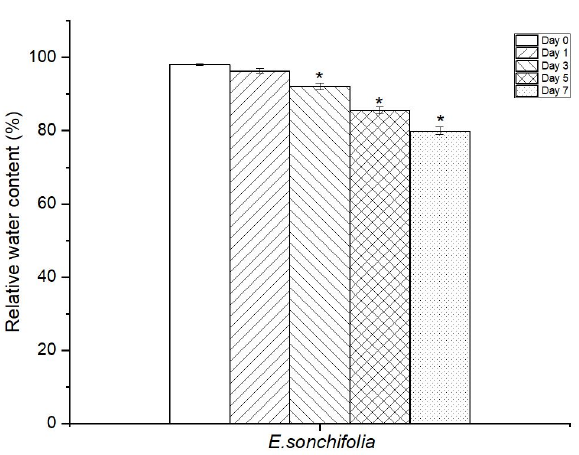
Figure 2. RWC of E. sonchifolia leaves during drought stress. The height of each bar and the error bar show the mean and standard deviation from 5 replicates. The column with single asterisk (*) adhered indicates significant differences (P < 0.05) as compared with day 0, determined by Dunnett’s